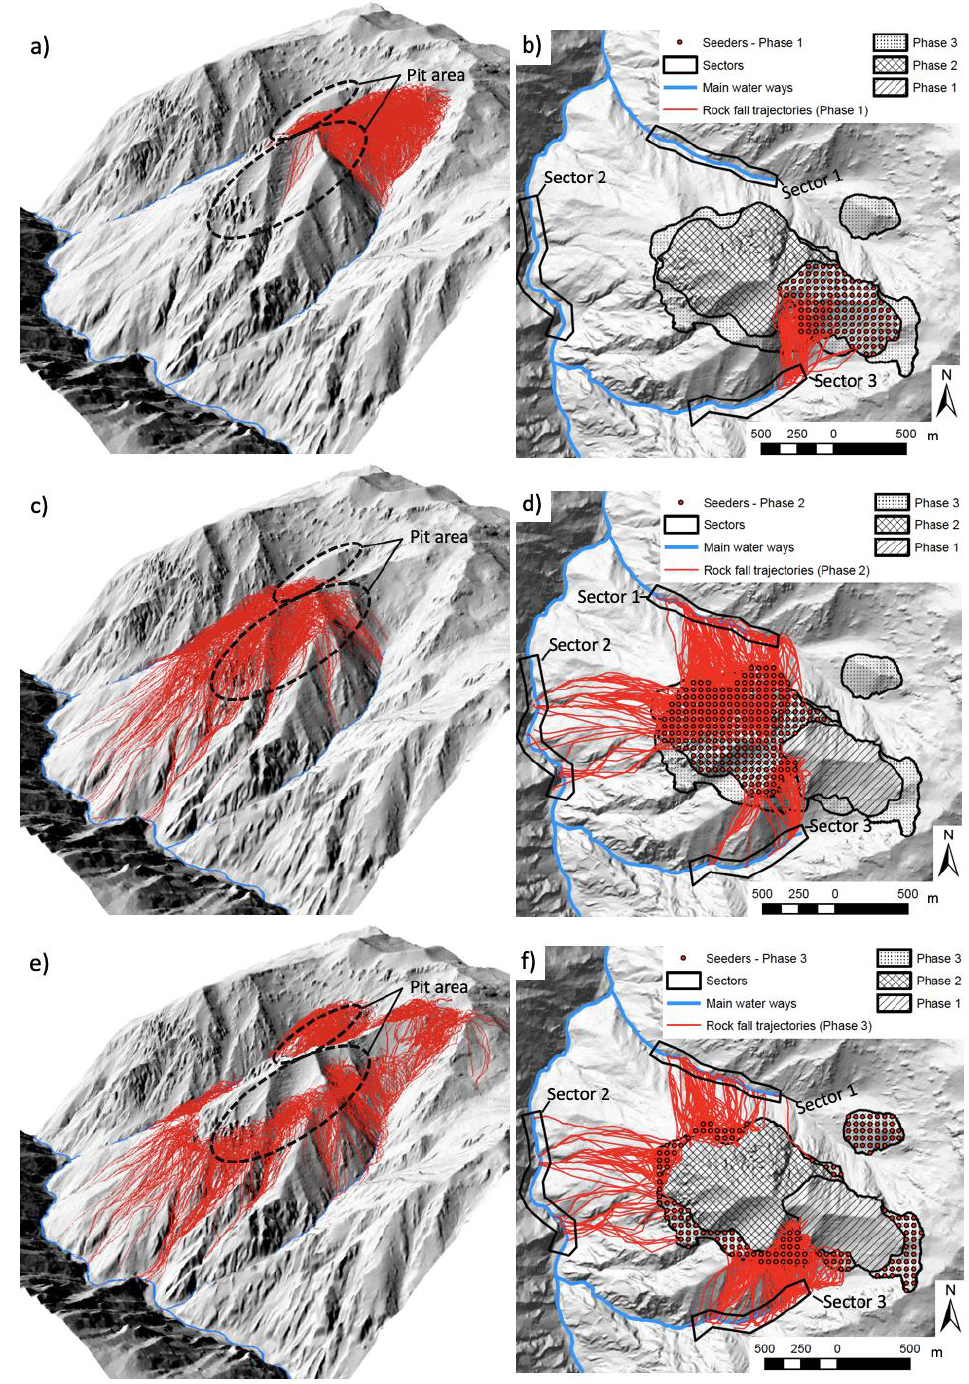
Figure 9. 3-dimensional rendering ( left ) and plan view ( right ) of rockfall trajectories for Phase 1 ( a,b ), Phase 2 ( c,d ), and Phase 3 ( e,f ).